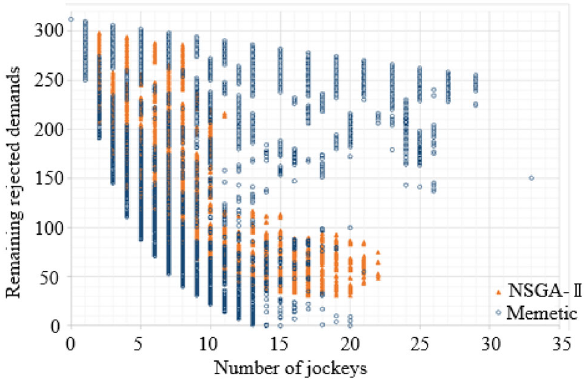
Fig. 7 Number of rejected demands according to the number of jockeys